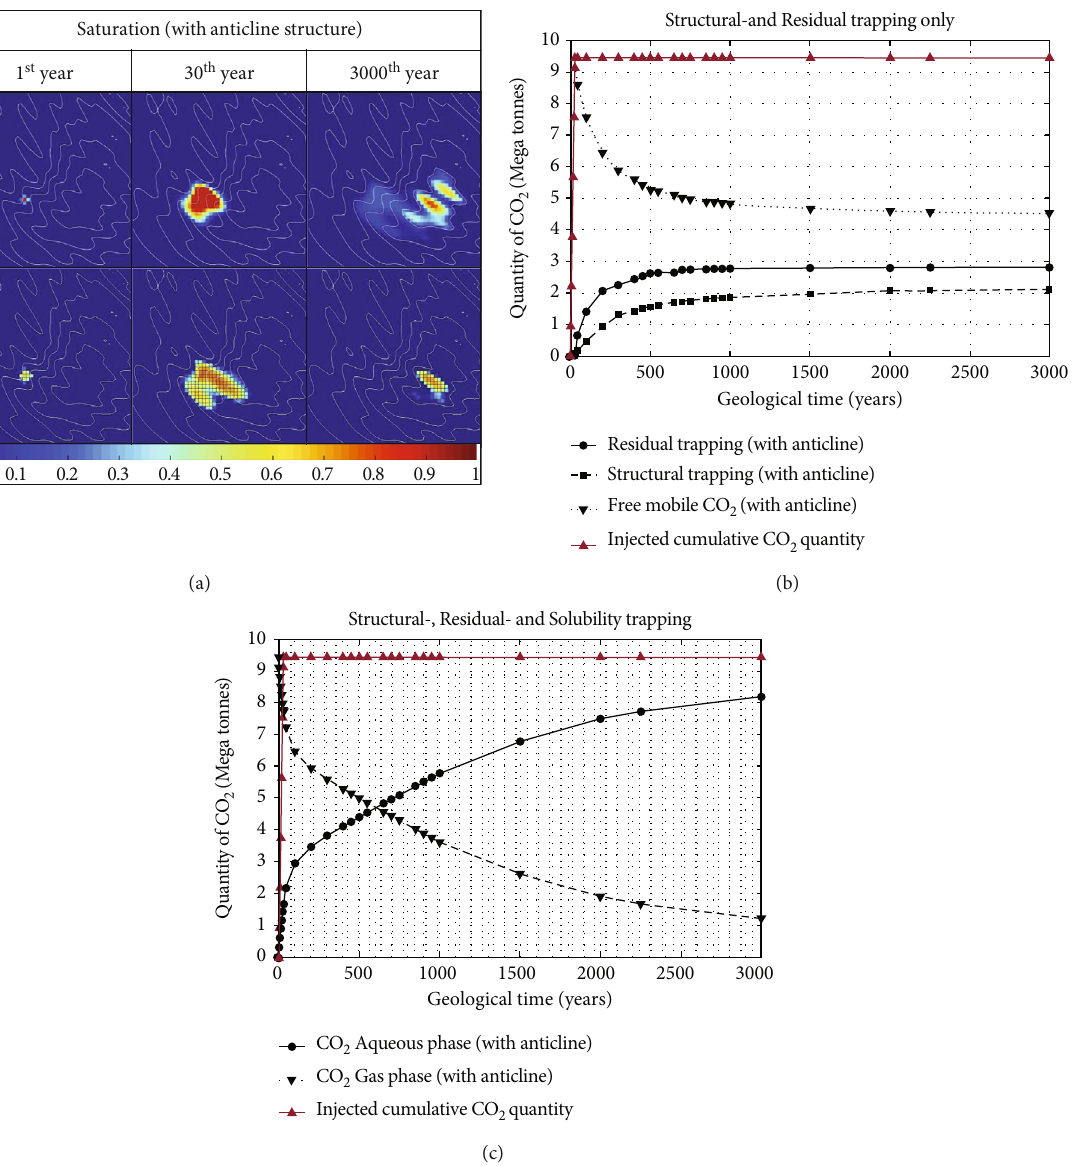
Figure 3: (a) Saturation of CO and residual trapping only represent ScCO saturation describes the injected CO mechanisms, (b) during structural and residual trapping (without CO